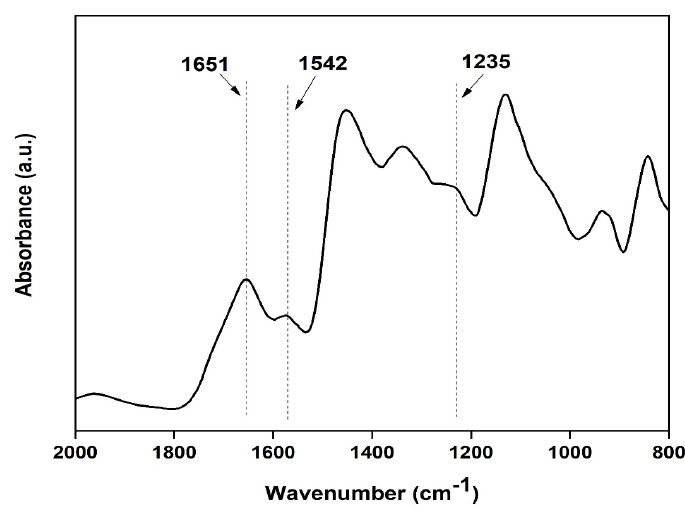
Figure 9. FTIR spectra of the silk fibroin casted transparent film.